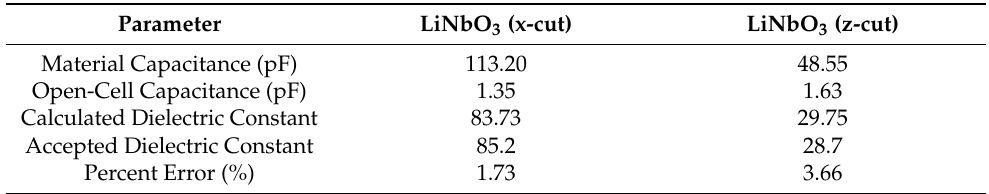
Table 4. Measured capacitance values and resulting dielectric constants calculations for multiple orientations of lithium niobate (LiNbO 3 ) single